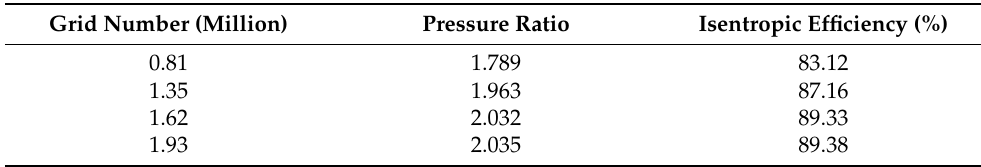
Table 4. Grid independence test.